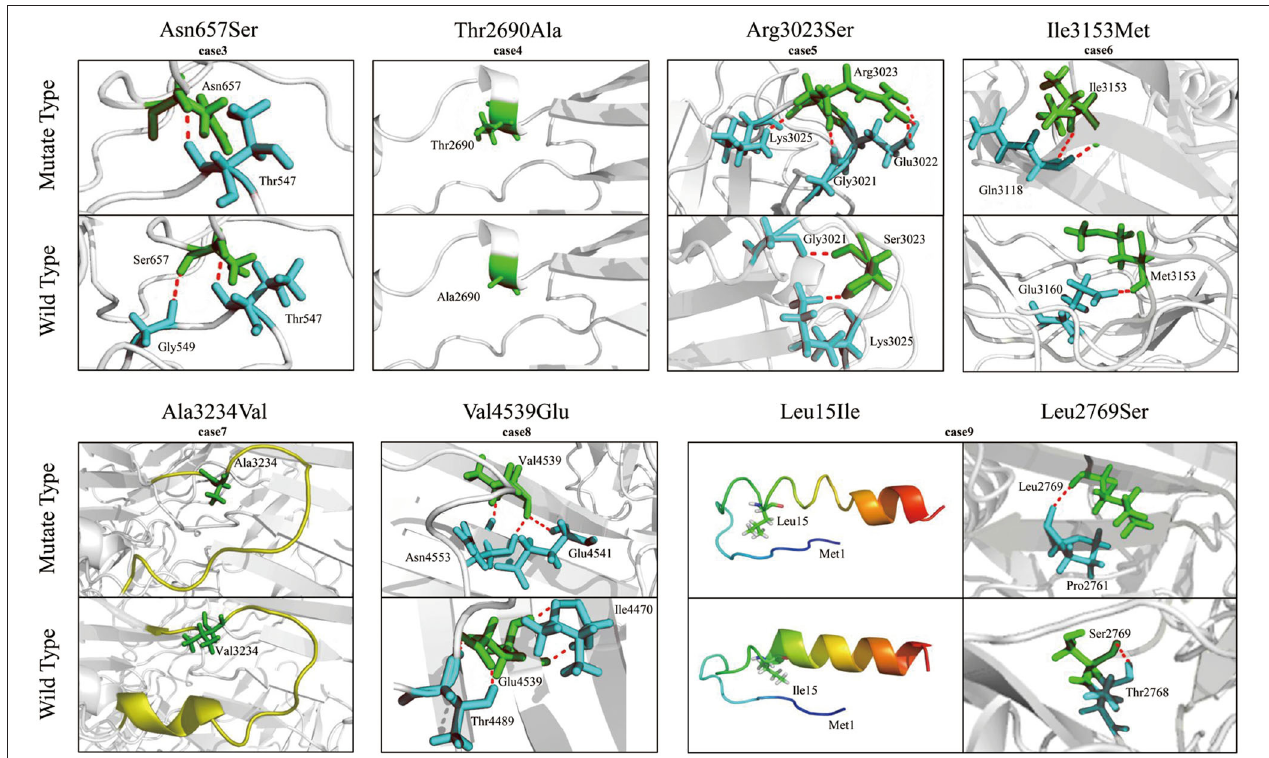
FIGURE 3 | Molecular modeling of VLGR1b and the mutants. Hydrogen bonds were changed in four heterozygous missense variants, namely, Asn657Ser, Arg3023Ser, Ile3153Met, and Val4539Glu. Mutant Thr2690Ala and Ala3234Val did not change any hydrogen bond. Among the compound heterozygous variants, Leu15 is located near an α -helix structure of the signal peptide, and the α -helix structure was extended in the L15I mutant. A new hydrogen bond was formed in the mutant Leu2769Ser. The hydrogen bonds are indicated by dotted red